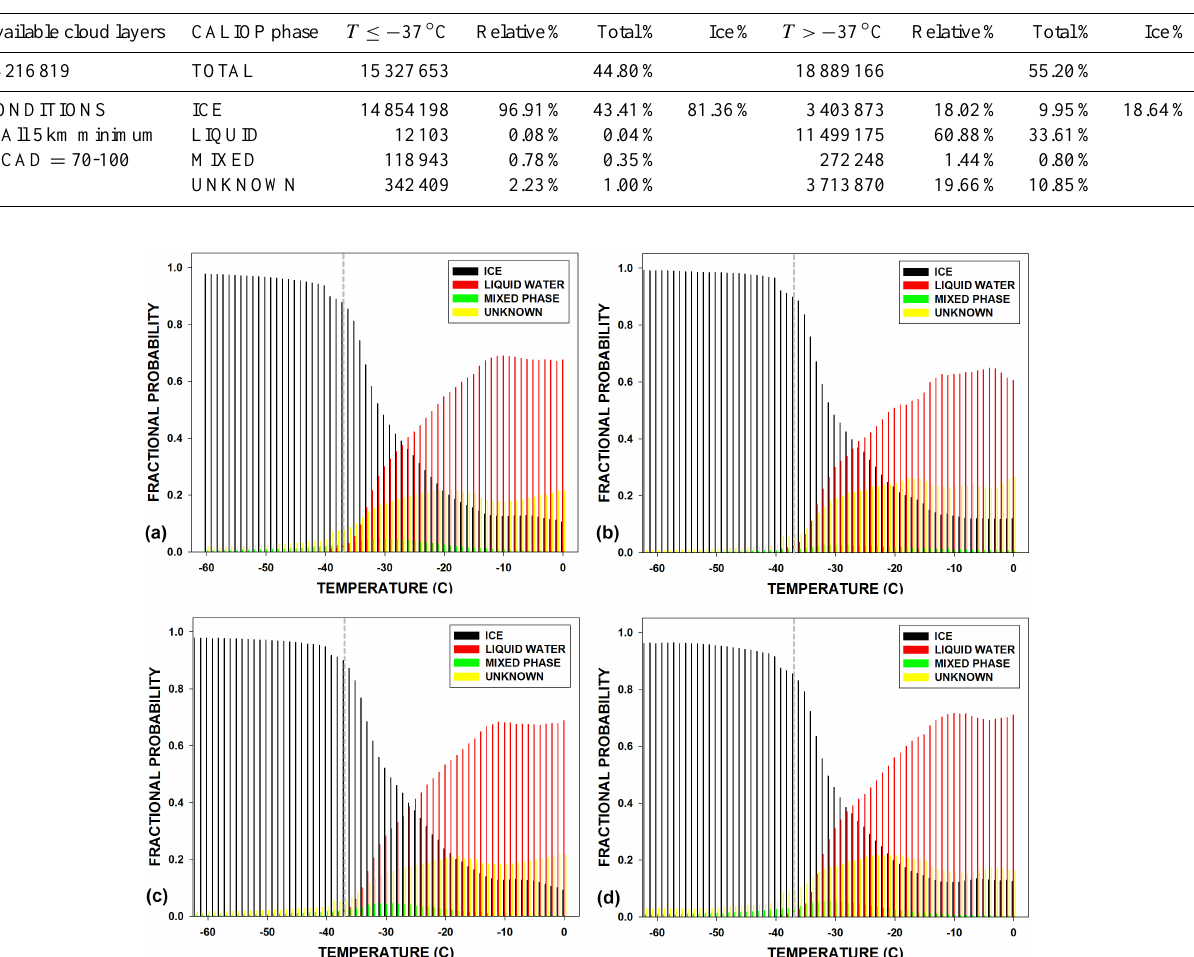
Table 1. Total number of cloud layers resolved in the 2012 CALIOP V3.02 L2_CPro-5km product, number of those clouds corresponding with cloud top height temperature ≤− 37 ◦ C, including sub-sample totals and relative, total and ice percentages (as denoted) as function of CALIOP-distinguished cloud phase, and those corresponding with a cloud top height temperature > − 37 ◦ C, again with corresponding itemized cloud phase sample sizes and fractional percentages. Data have been filtered for polar stratospheric cloud occurrence.